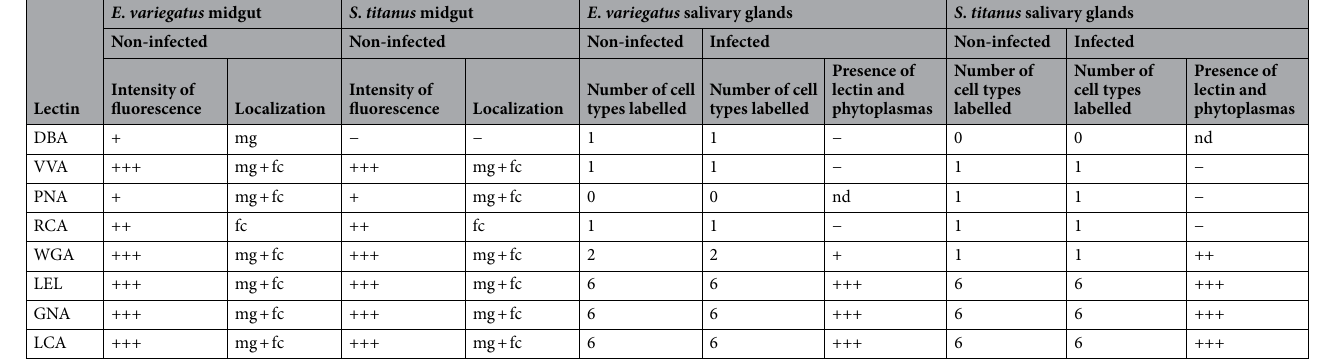
Table 2. Binding of the fluorescent lectins to the apical surface of midgut and basal surface of salivary gland cells of S . titanus and E . variegatus . nd not determined, fc filter chamber, mg